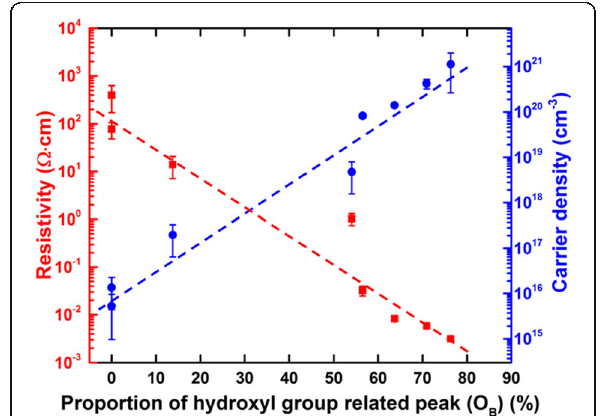
Fig. 8 Electrical resistivity and carrier concentration as a function of the hydroxyl group-related O B peak proportion (dashed lines are guides of the